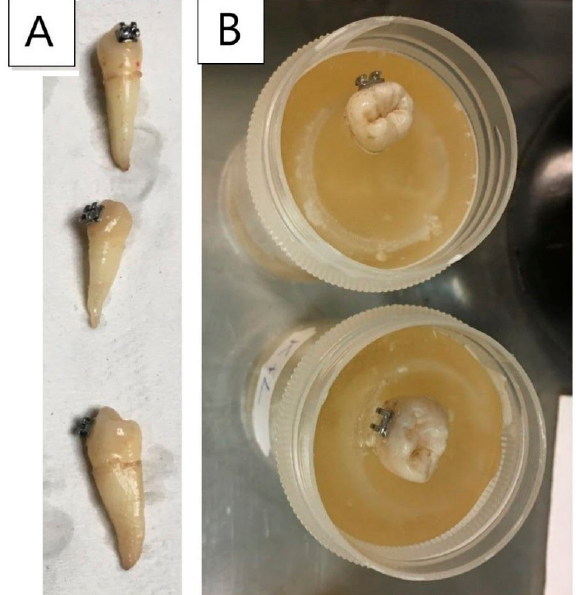
Figure 1. Samples: ( A ) teeth with an orthodontic bracket prepared for mechanical tests; ( B ) samples dipped in a polyethylene container using DuracrylTM Plus denture base resin (Spofa Dental, Jiˇc í n, Czech